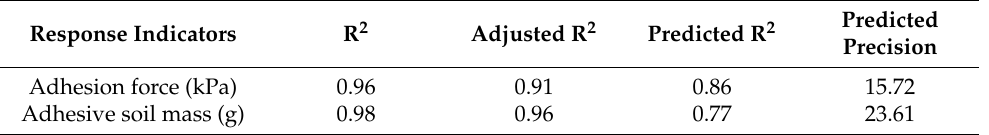
Table 5. Fit statistics for the response